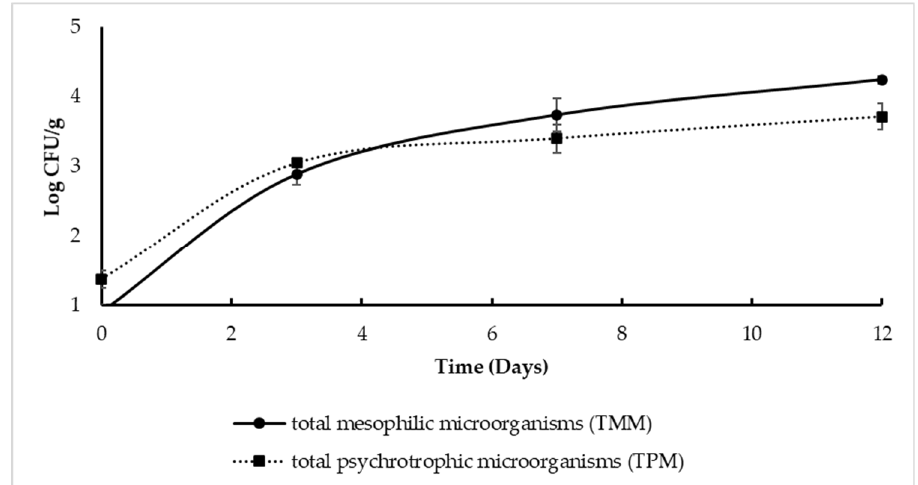
Figure 4. Total mesophilic microorganism (TMM) and total psychrotrophic microorganisms (TPM) densities in pomegranate aril samples without any treatment (controls) during storage at refrigerated conditions.